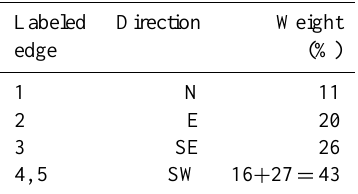
Fig.10 Simplified and labeled Fig. 10. Simplified and labeled Voronoi edges with normals. Voronoi edges with normals. Table 3. Qualitative description of direction relations from R to V in Fig.